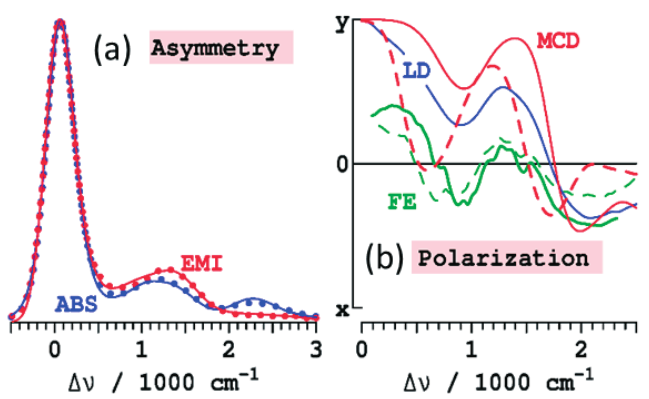
Fig. 7. Observed and interpreted low-resolution spectra for Chl-a in ether at 295 K. (a) Asymmetry between the 5CO absorption 𝐴 ( Δ ν ) ν and reflected emission 𝐸 (– Δ ν ) ν 3 spectra from experiment [125] (dots) and from a model including non-adiabatic coupling between Q and Q [63] (solid lines). (b) Spectral polarizations deduced for 5CO (solid lines) and 6CO (dashed lines) from x y experimental data [63]: blue – LD [48], red – from analytical data inversion of MCD and absorption spectra [50], green – from polarized fluorescence excitation (FE) [42] interpreted using the Q – Q non-adiabatic coupling x y